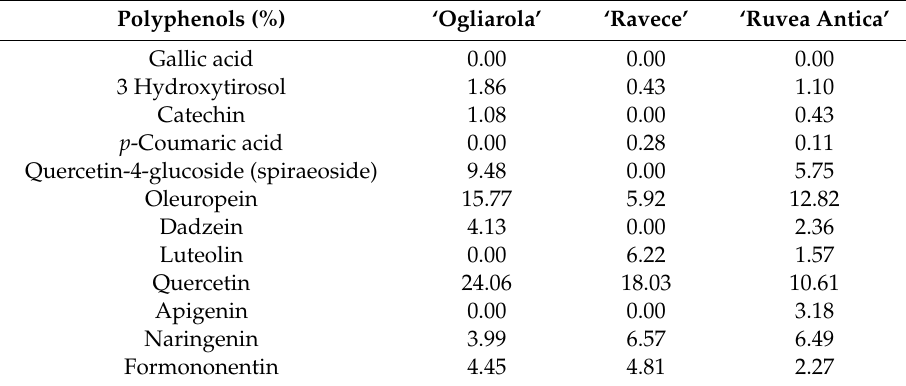
Table 3. Polyphenol composition, obtained by Ultra Pressure Liquid Chromatography (UPLC), of the three PF extracts of Ogliarola , Ravece and Ruvea antica EVOOs. The data are reported as percentage of total polyphenols.